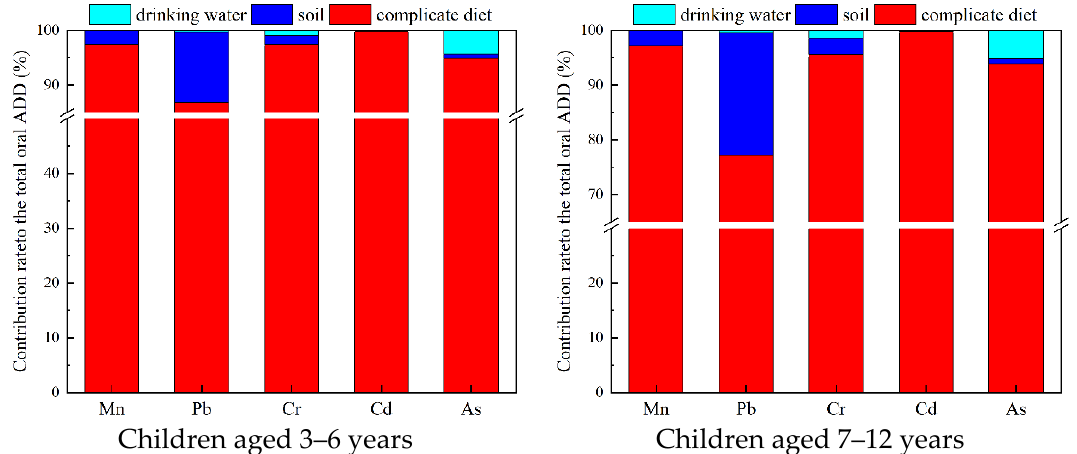
Figure 1. The contribution of exposure to metal(loid)s via the ingestion of food, drinking water, and soil to the total daily oral exposure dose for children (3–6 years and 7–12 years, respectively).